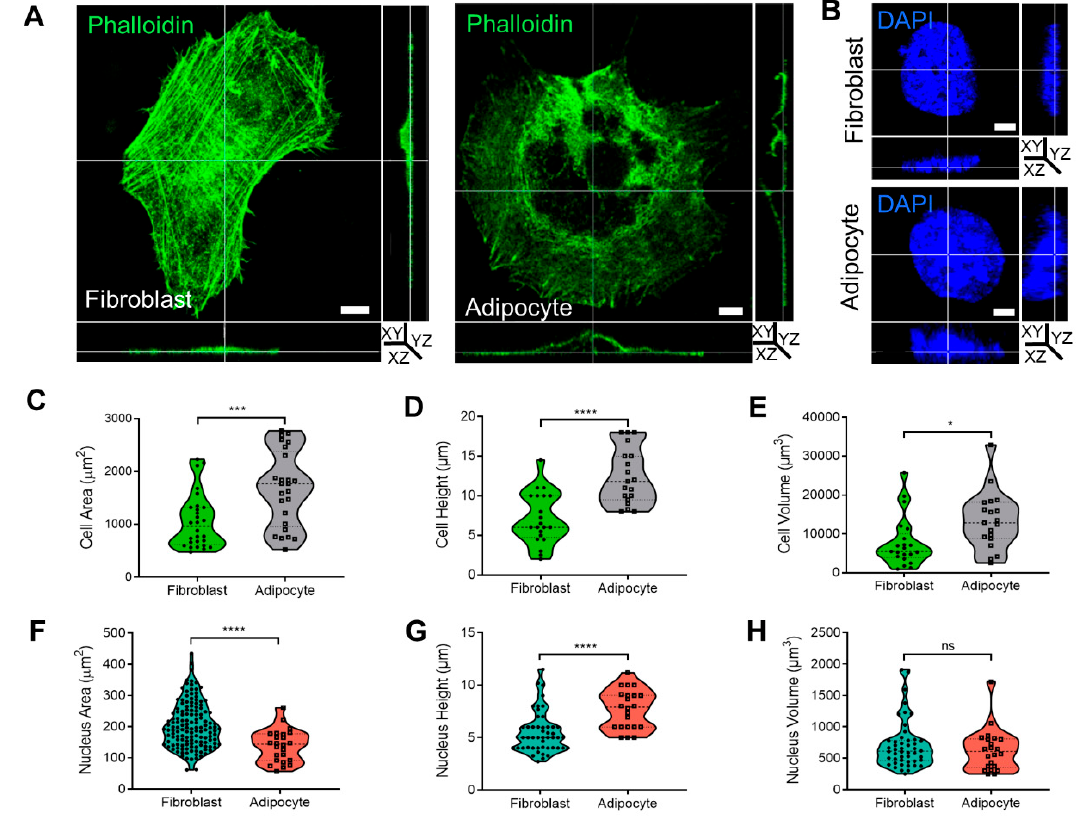
Figure 2. Cell shape, cytoskeleton, and nucleus measurement in 3D during adipogenesis. ( A , B ) Three dimensional confocal and Z stack micrograph of cytoskeleton’s actin staining (phalloidin-FITC) or nuclei (DAPI) ( × 630 magnification) on images of YZ and XZ orientation. ( C , F ) The measurement of cells (n = 28, fibroblast; and n = 25, adipocyte) and nuclei (n = 143, fibroblast; and n = 24, adipocyte) area. ( D , G ) Cells and nuclei height quantification was detected from the bottom to the top visible actin and DAPI staining (cells: n = 21, fibroblast, and n = 19, adipocytes); nuclei (n = 49 and n = 22, respectively). ( E , H ) Cells and nuclei volume quantification (n = 21, fibroblast; n = 19, adipocytes); nuclei (n = 48; n = 22, respectively). Data were presented as mean ± SD and statistics were analyzed by a two-tailed, unpaired Student’s t-test (ns p > 0.05, * p < 0.05, *** p < 0.001, **** p <